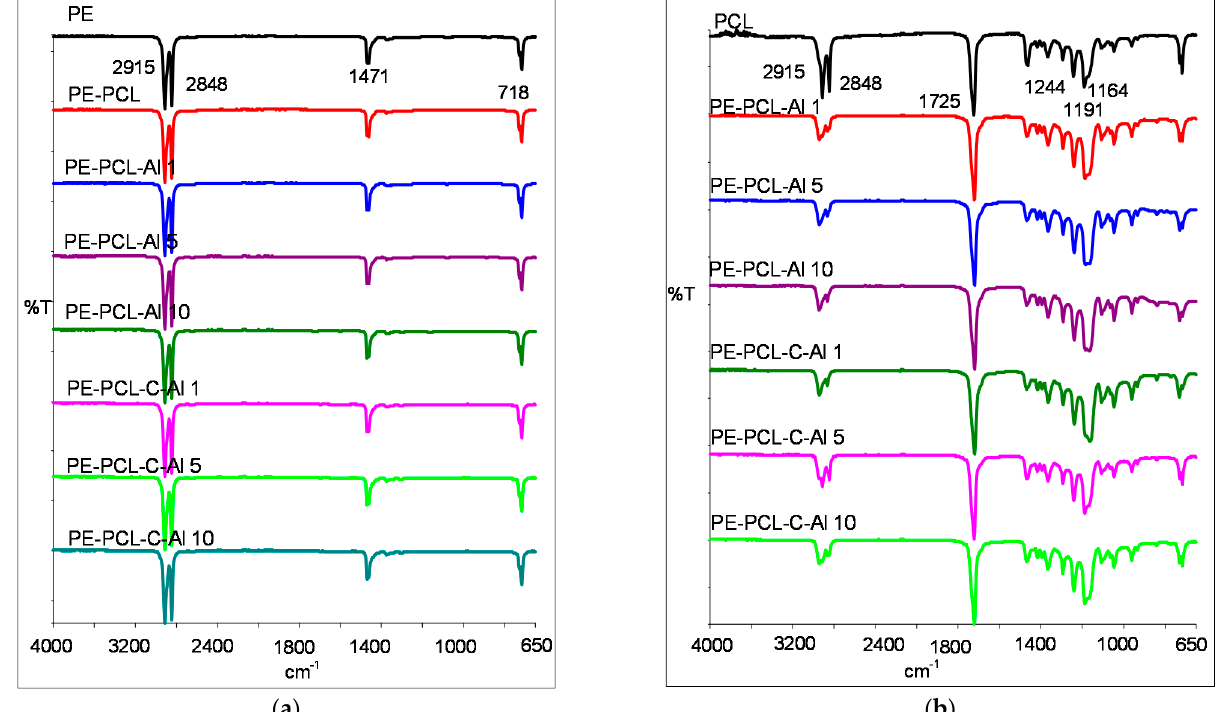
Figure 5. FTIR spectra of PE/PCL films: ( a ) on PE side, ( b ) on the side of the PCL coating.